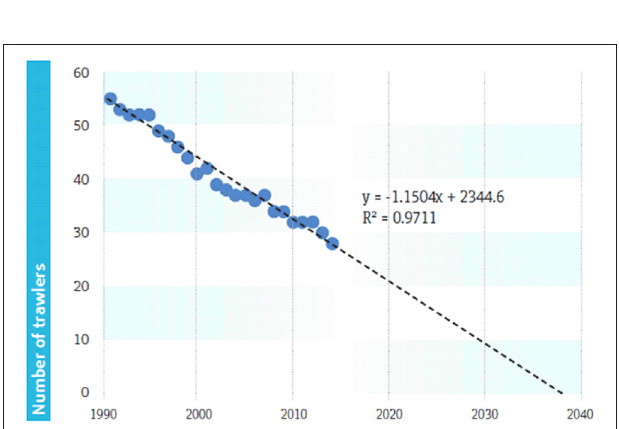
FIGURE 5 | Scheme of the management measures proposed in this study for the demersal fisheries from the Balearic Islands (western Mediterranean).